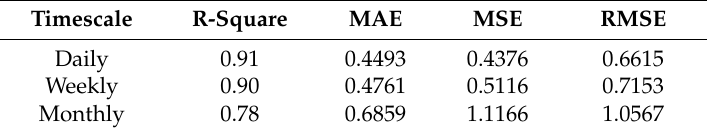
Table 2. Forecasting performance evaluation for different